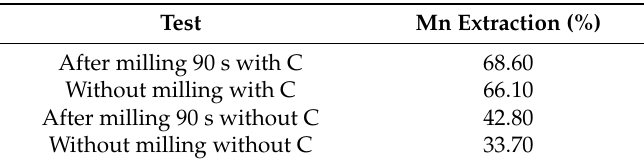
Figure 4. Description of the acid leaching at temperatures <300 °C.